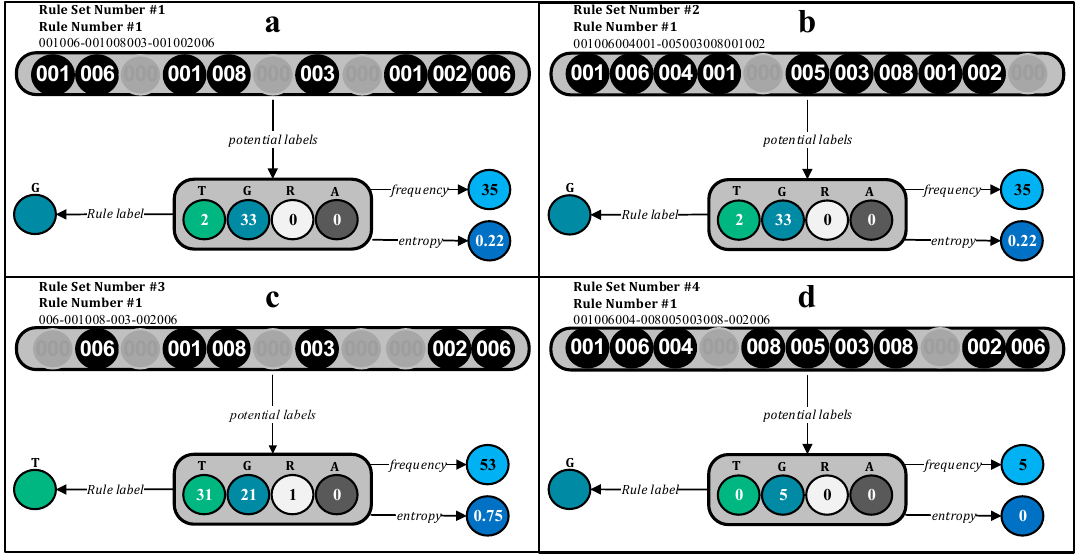
Figure 2. Schematic demonstration of ( a , b ) reliable and ( c , d ) unreliable rules extracted using DoTRules. The black circles represent the segment values of randomly selected spectral bands composing di ff erent rules for one target pixel. Considering rule sets number #1 and #2, the latter will have more impact in combining votes due to its larger length.